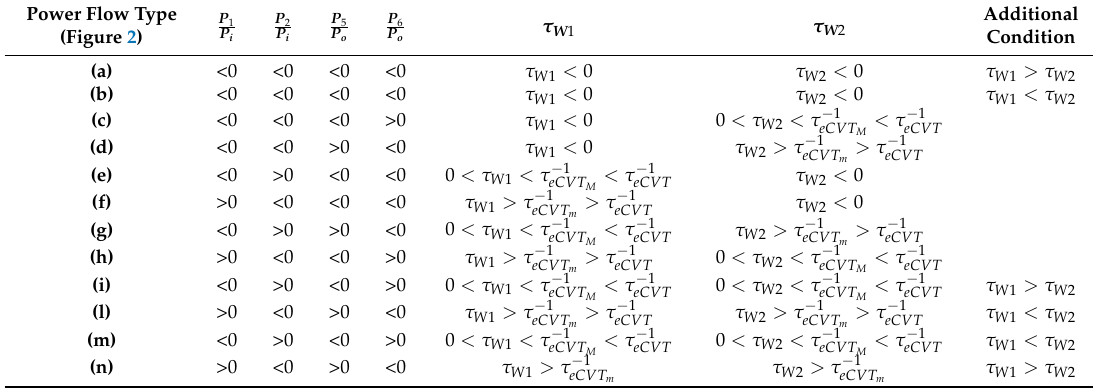
Table 2. Case 1—Power flows for each range of the planetary gear constants.